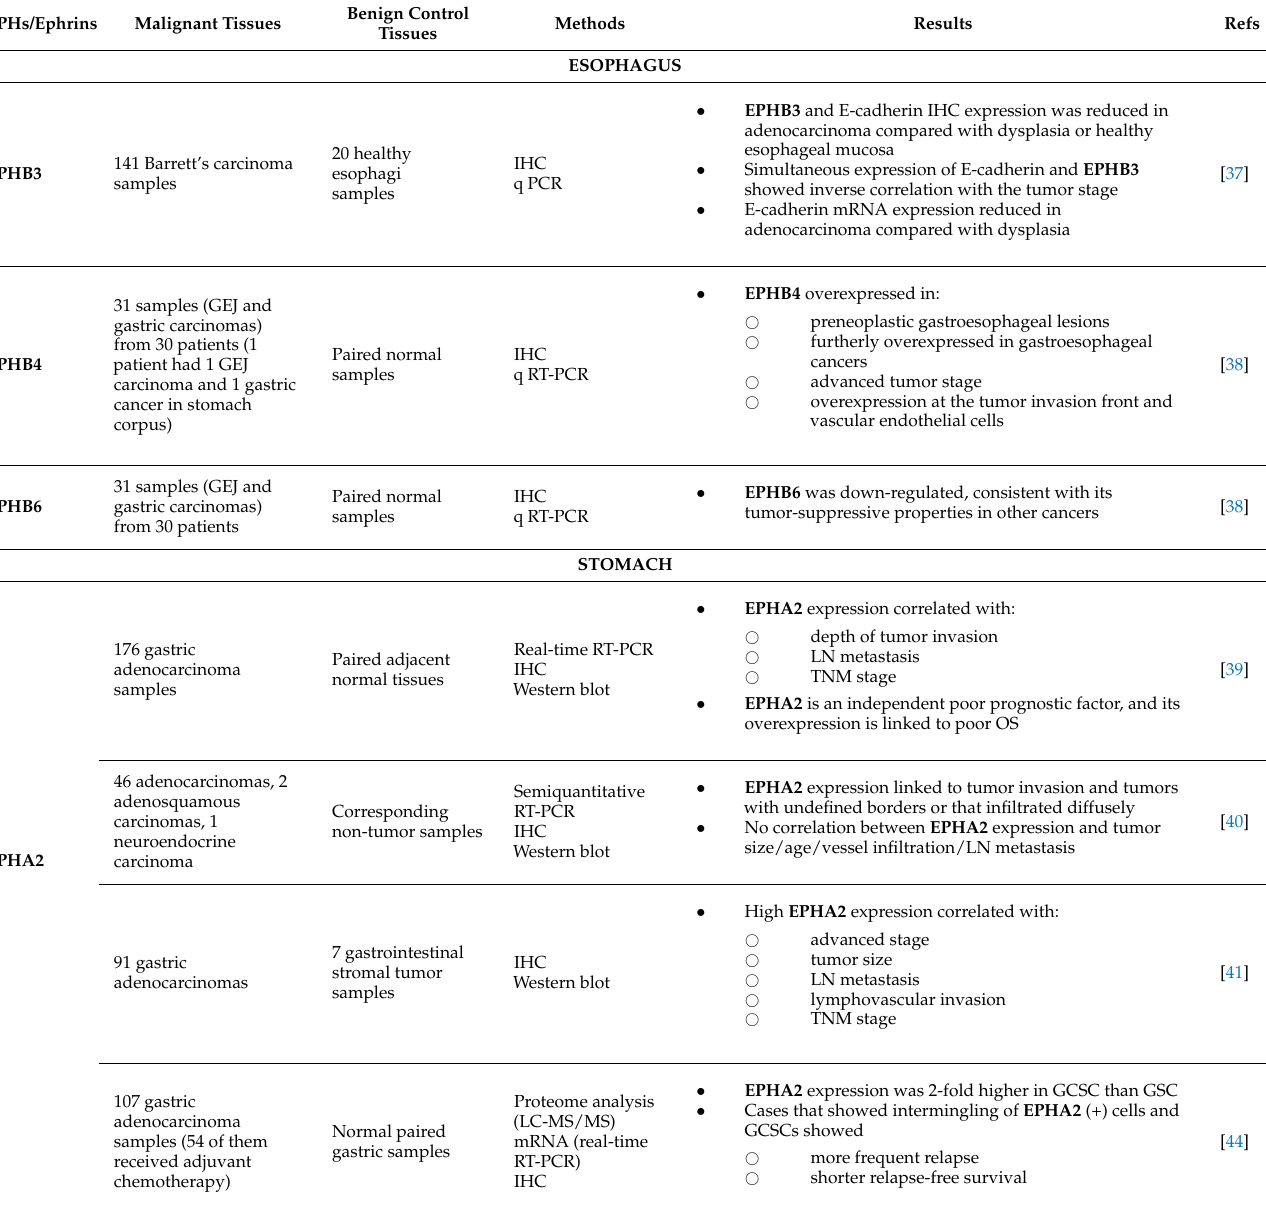
Table 3. EPHs/ephrins (bold) studied in solid tumors of the gastrointestinal tract, liver, biliary tract, and pancreas and correlations with clinicopathological